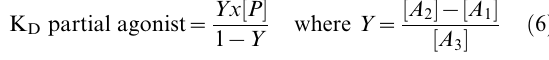
Figure S2 MAPKinase activation of the wildtype b 1- adrenoceptor and polymorphic variants. MAPKinase activation in A wildtype cells, B Gly49/Gly389 cells and C Ser49/Arg389 cells. Bars are mean 6 s.e.mean of triplicate determinations. These single experiments are representative of 3 separate experiments in each case and demonstrate a lack of ERK1/2 MAPKinase stimulation by b -adrenoceptor ligands. Figure S3 Correlation plot and statistical analysis for the affinity of all the ligands from Table S1 in File S1 for the WT (clone T88 x-axis) and WT (clone T3), polymor- phic variants, and transient populations (y-axis). The linear regression lines are not shown on the graph to ensure that the symbols are still visible. This shows that the affinity of ligands for the different b 1-adrenoceptor variants is similar to that for the wildtype receptor. File S1 Table S1, Affinity of b -adrenoceptor ligands for the wildtype and polymorphic variants of the b 1- adrenoceptor. Table S2, Affinity of b -adrenoceptor ligands for the wildtype and polymorphic variants of the b 1-adrenoceptor in transiently transfected popula- tions. Table S3, Agonist responses occurring via the wildtype and polymorphic variants of the b 1-adrenocep- tor. Table S4, Agonist responses for ligands with biphasic responses at the wildtype and polymorphic variants of the b 1-adrenoceptor in two additional stable cell lines for each receptor and transiently transfected cells. Table S5, Relationship between receptor expres- sion level and efficacy of partial agonists at the two agonist conformations of the wildtype and polymorphic variants of the b